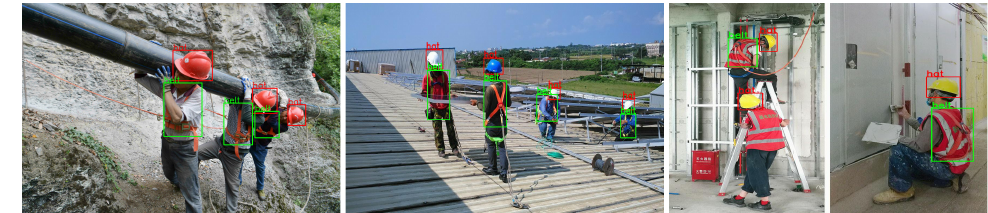
Figure 5. Sample images of our proposed object detection